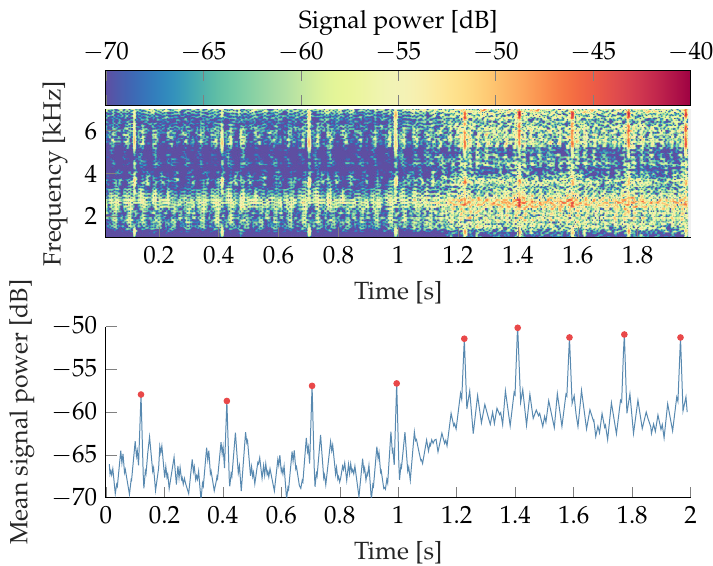
Figure 8. Spectrogram ( top ) and mean signal power ( bottom ) of the vibration signal of the gearbox with synthetic damage at gear z 1 in the range of